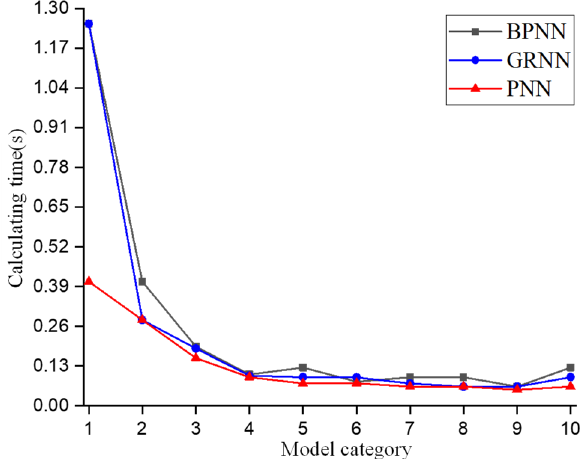
Figure 13. Comparison of calculation time of different input models and different classifiers.